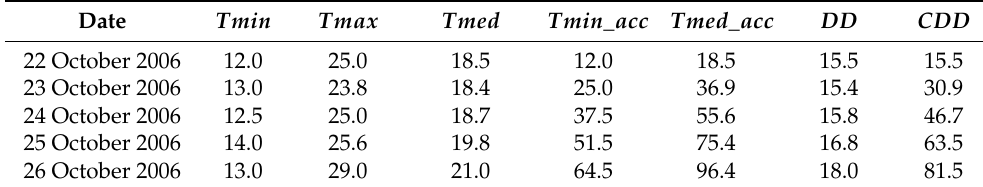
Table 2. Input data used in the